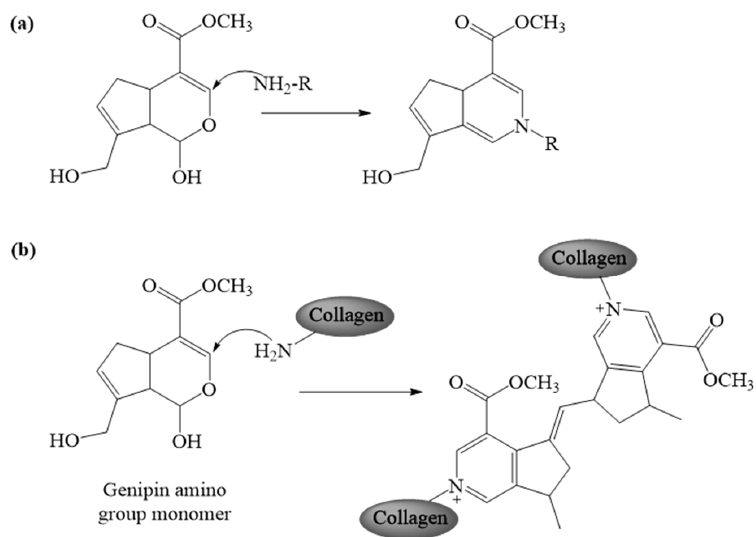
Figure 1. ( a ) Genipin ‐ amino group monomer formation by reaction of genipin with N ‐ terminal or side chain amine group of a lysine residue in a protein like collagen. ( b ) The reaction of the genipin ‐ amino group monomer with the amine group of either N ‐ terminus/side chain of lysine resulting in a non ‐ cytotoxic crosslinked form of intermolecularly crosslinked collagen proteins.